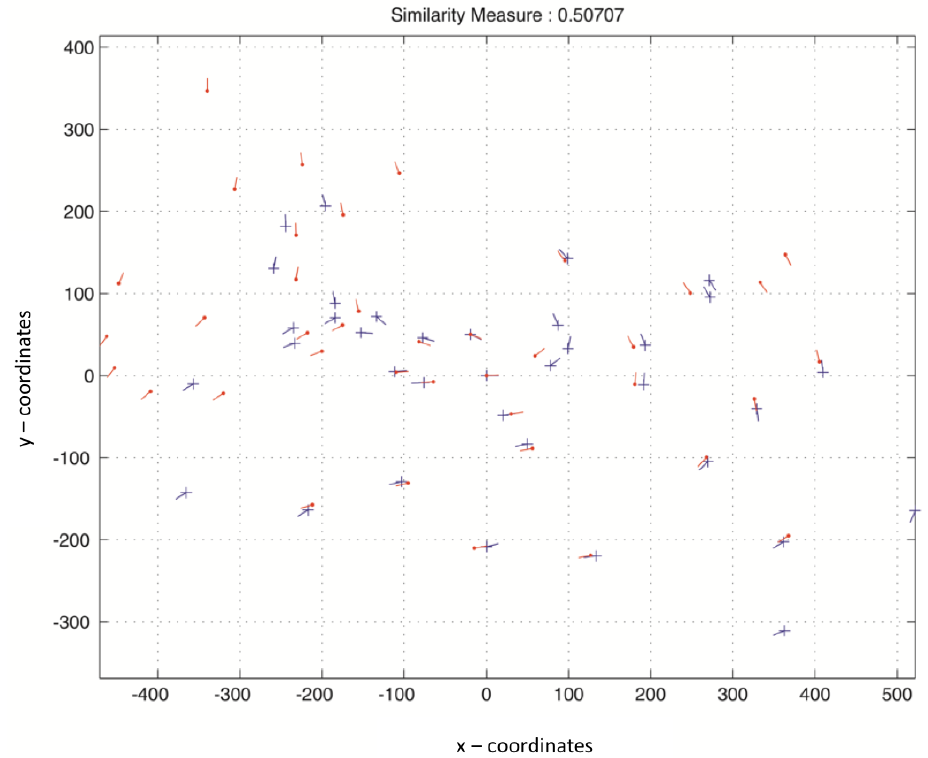
Figure 7. Matching score between original and transformed fingerprint templates.